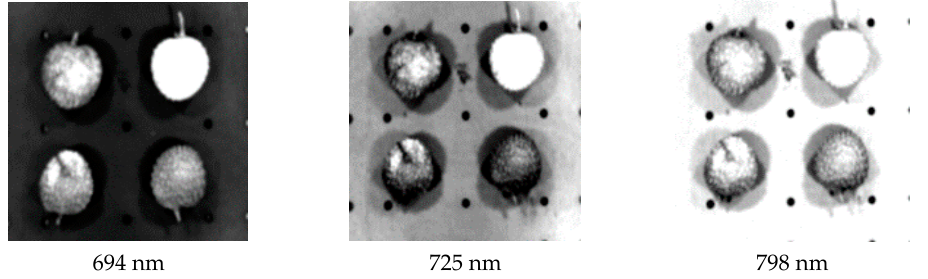
Figure 9. Single-band greyscale image based on sensitive bands of PC3.